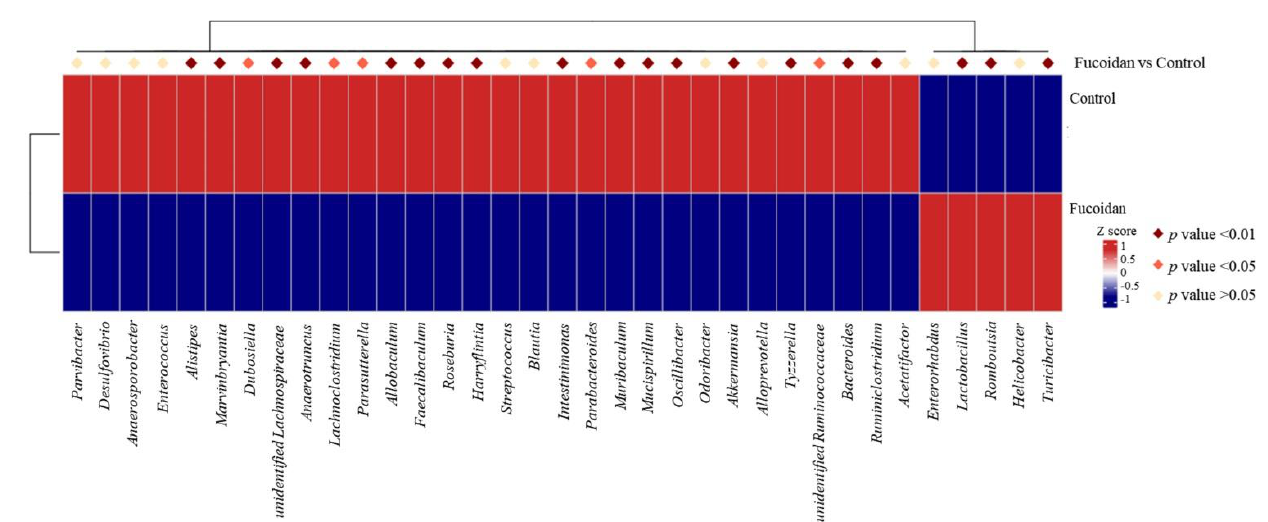
Figure A3. Fucoidan supplementation caused distinct shifts in the bacterial genera in mice .